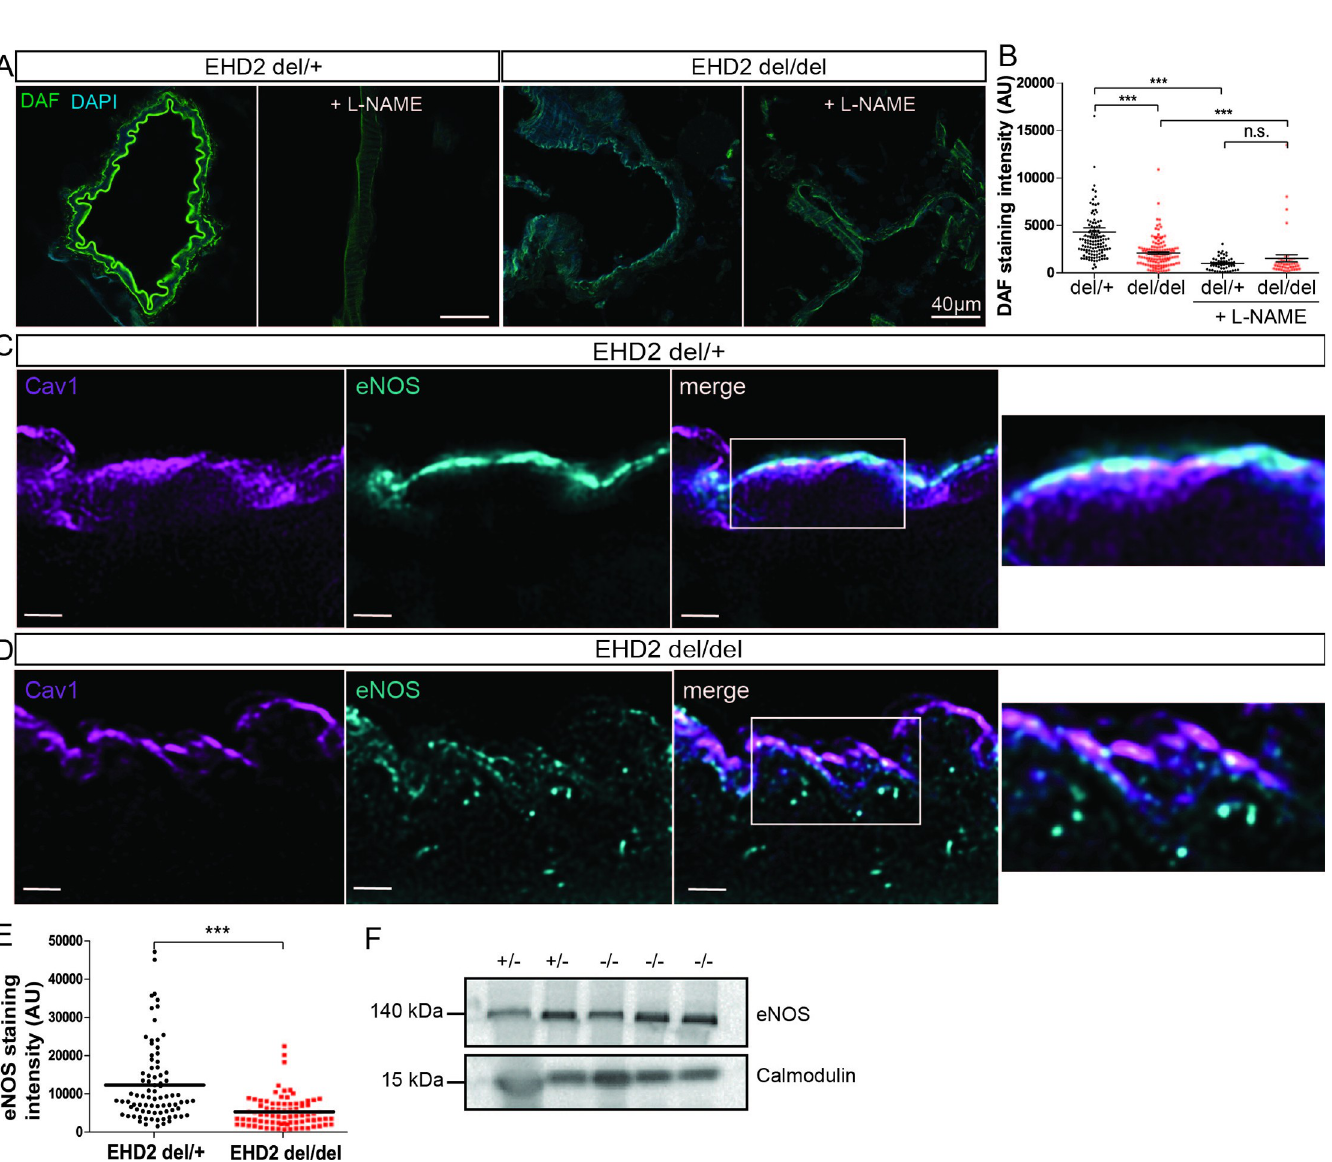
Fig 3. Decreased NO concentrations and impairment of eNOS localization in EHD2 del/del mesenteric arteries. (A) NO abundance was determined by DAF staining of EHD2 del/+ and del/del mesenteric arteries either untreated or pre-treated with L-NAME. (B) DAF staining intensity is significantly reduced for EHD2 del/ del arteries compared to EHD2 del/+ (L-NAME: n(del/+) = 51/3; n(del/del) = 43/3; untreated: n(del/+) = 121/3; n(del/del) = 127/3). (C) STED imaging of eNOS (blue) and Cav1 (magenta) in EHD2 del/+ mesenteric artery cryostat sections illustrates eNOS localization at the plasma membrane of the small arteries in close proximity to caveolae (merge). (D) EHD2 del/del mesenteric arteries showed reduced eNOS staining at the plasma membrane, instead eNOS was detected within the cytosol of endothelial cells. Scale bar 4 μ m. See also S4 Fig. (E) Plasma membrane eNOS staining was analyzed and revealed decreased eNOS fluorescence intensity in EHD2 del/ del mesenteric arteries compared to EHD2 del/+ (n(del/+) = 83/3; n(del/del) = 81/3). (F) Analysis of total eNOS protein concentration in tissue lysates obtained from EHD2 del/+ and del/del small vessels by Western Blot. Calmodulin was used as loading control. Graphs illustrate each replicate with mean +/- SE, t-test or Mann Whitney U test were used to calculate significance, ��� P < 0.0001; n.s. not